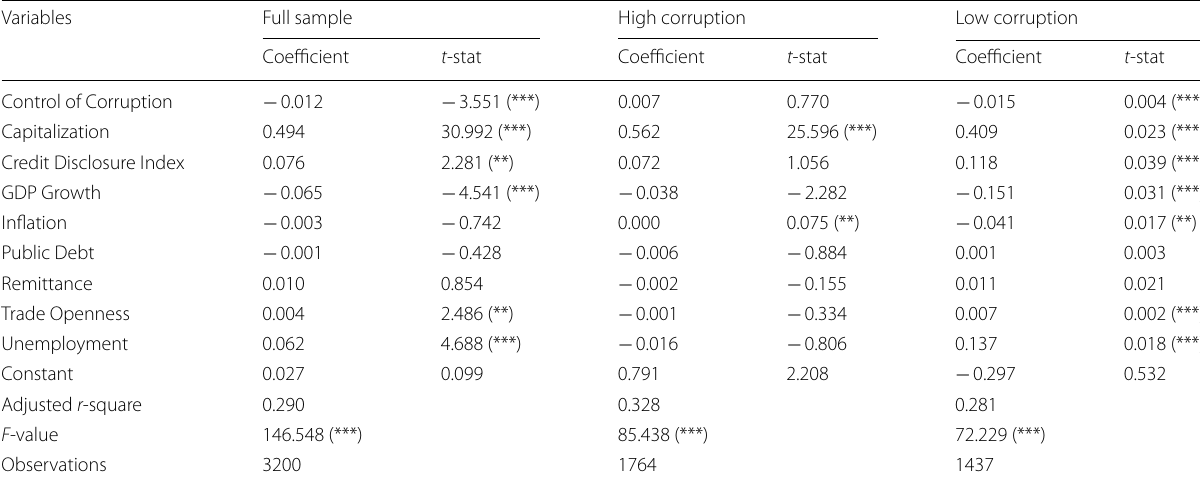
Table 8 Robustness test (alternative corruption